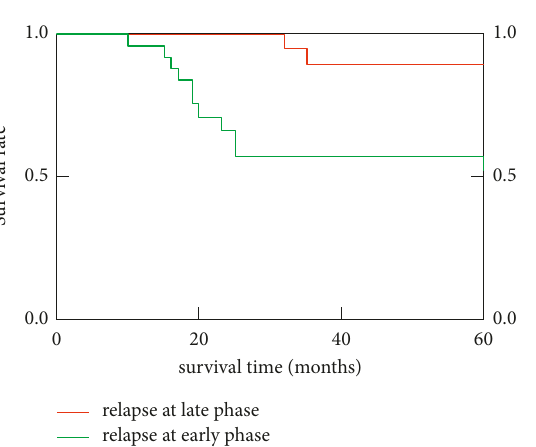
Figure 4: The prognosis and survival curve of breast cancer pa- tients with recurrence in different